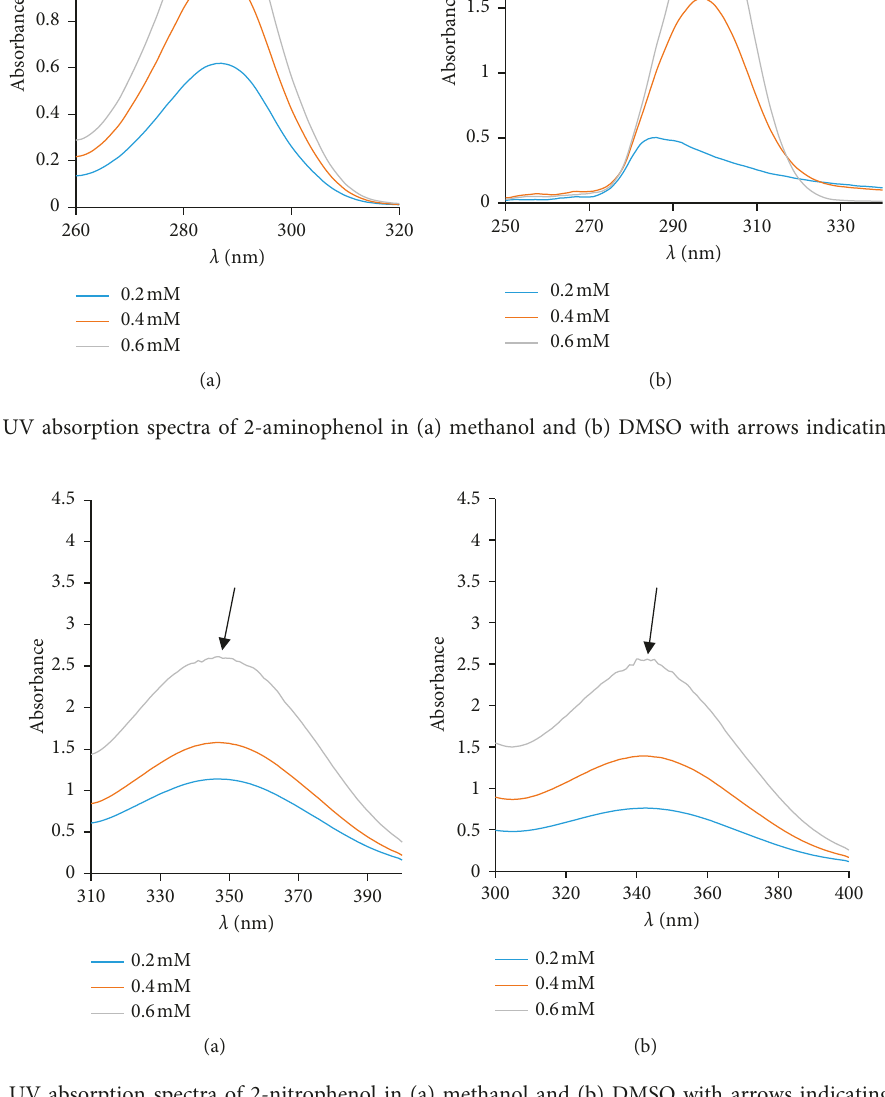
Figure 5: UV absorption spectra of 2-nitrophenol in (a) methanol and (b) DMSO with arrows indicating the λ Table 1: Experimentally determined wavelength of maximum absorption ( λ Solvent Phenol 2CPH 2APH 2NPH Methanol 272 (2344) Dimethyl